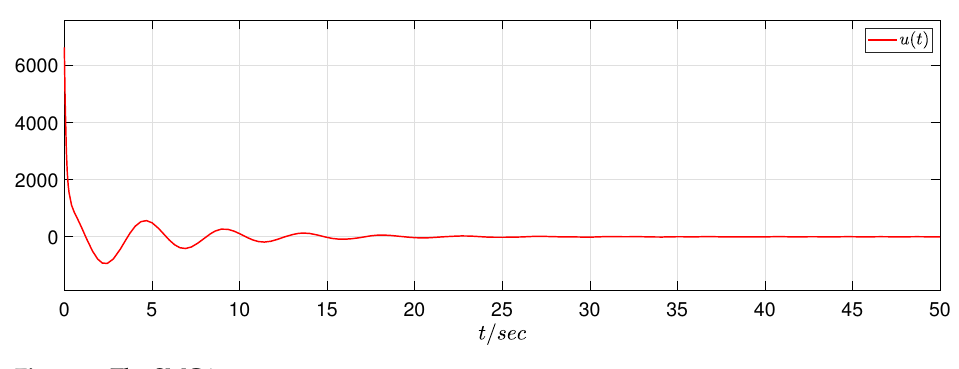
Figure 7. The SMC input.